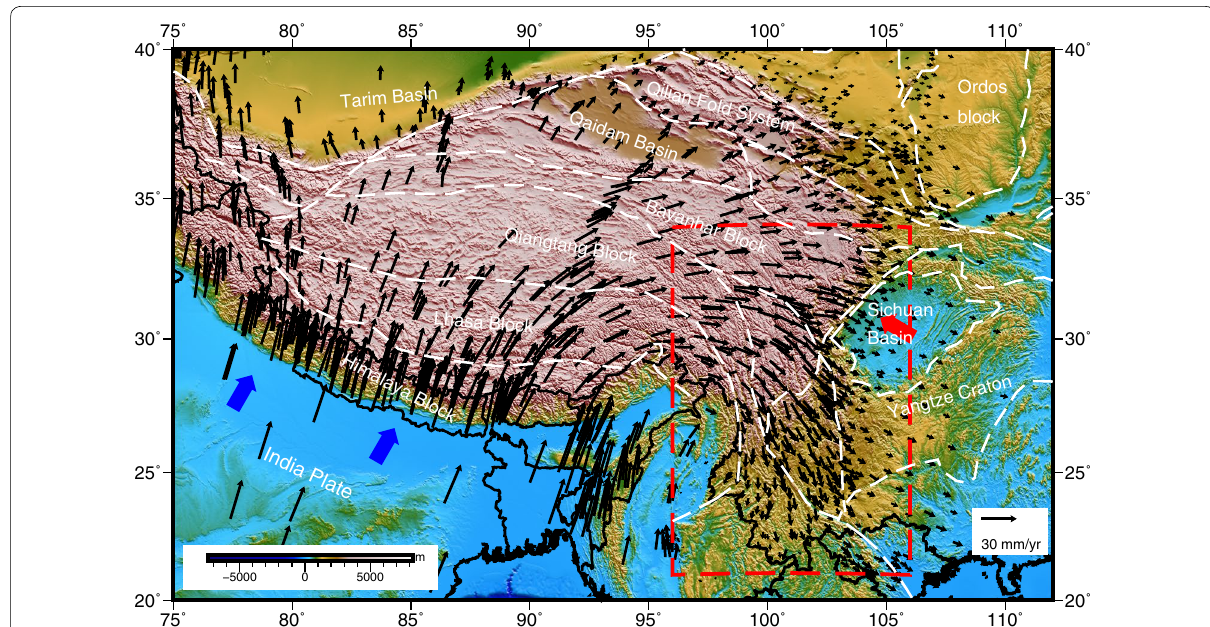
Fig. 1 Tectonic map of the Tibetan Plateau. The red-dashed frame denotes the study area, the Sichuan–Yunnan fragment (SYF). The black arrows are the GPS horizontal rates (Pan et al. 2018). The white-dashed line denotes the boundaries of blocks (Zhang et al. 2003). The blue arrows denote the movement direction of the India plate, and the red arrow denotes the block of the Sichuan Basin. The digital elevation model data are from (Amante and Eakins